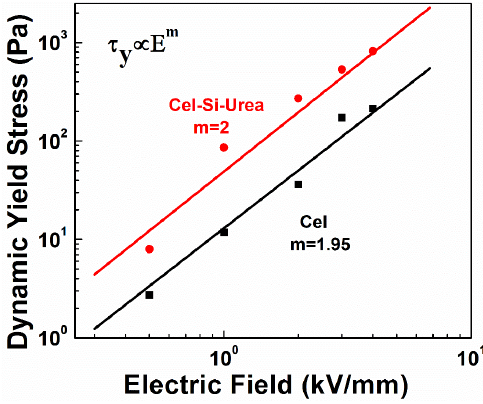
Figure 9. Dynamic yield stress of the ER fluids as a function of electric field strength (symbols: dynamic yield stress obtained from CCJ model, lines: fitting of power-law equation).